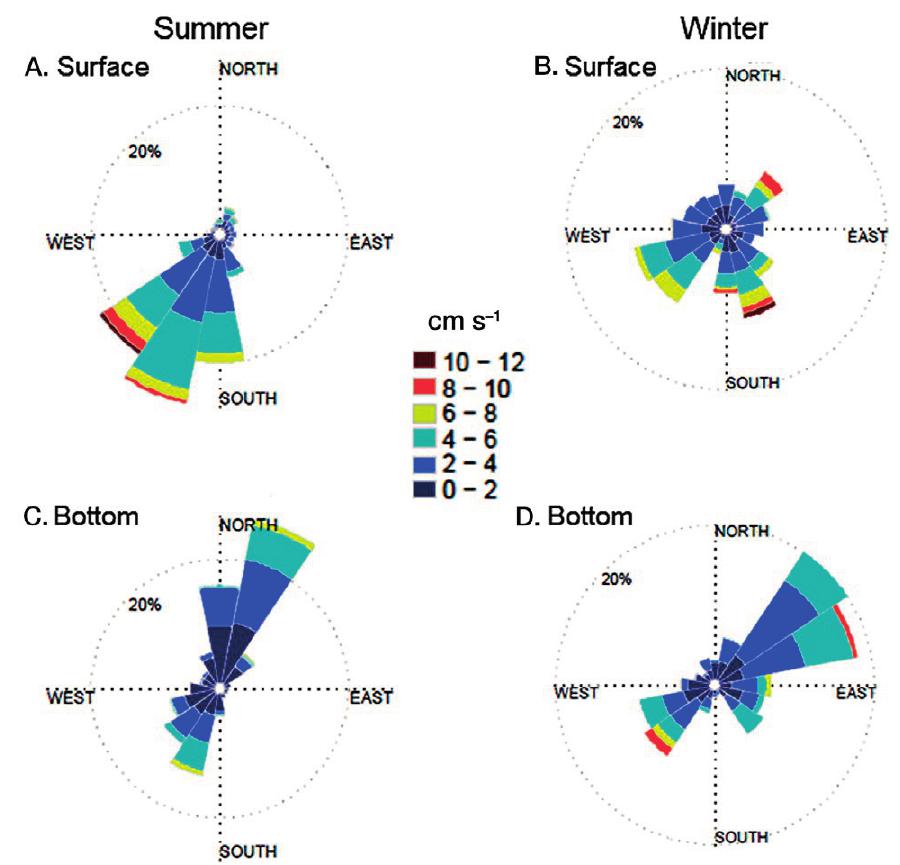
Fig 3. – Current roses for 1-m surface and bottom filtered currents at A1 in summer 2013 (A and C) and winter-spring 2014 (B and D). Both surface and bottom velocities are grouped in a 1-m depth layer. Colour data show the corresponding current speed, grouped in 2-cm s –1 intervals and with 16 directions. Units in cm s –1